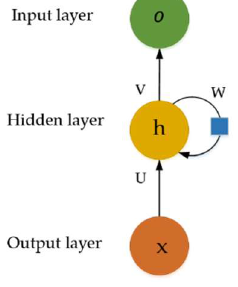
Figure 2. RNN model structure.